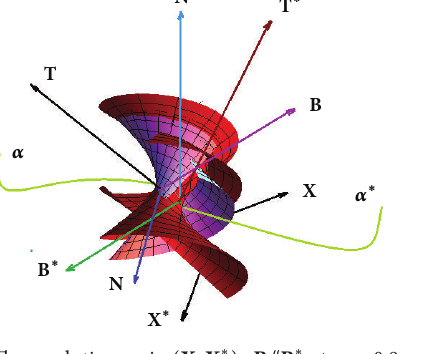
Figure 2: The evolution pair ( X , X ∗ ) , B U B ∗ , 𝑡 = 0.8 , 𝜓 = 1 , 𝑠 ∈ [−𝜋,𝜋] , V ∈ [−6,6] .